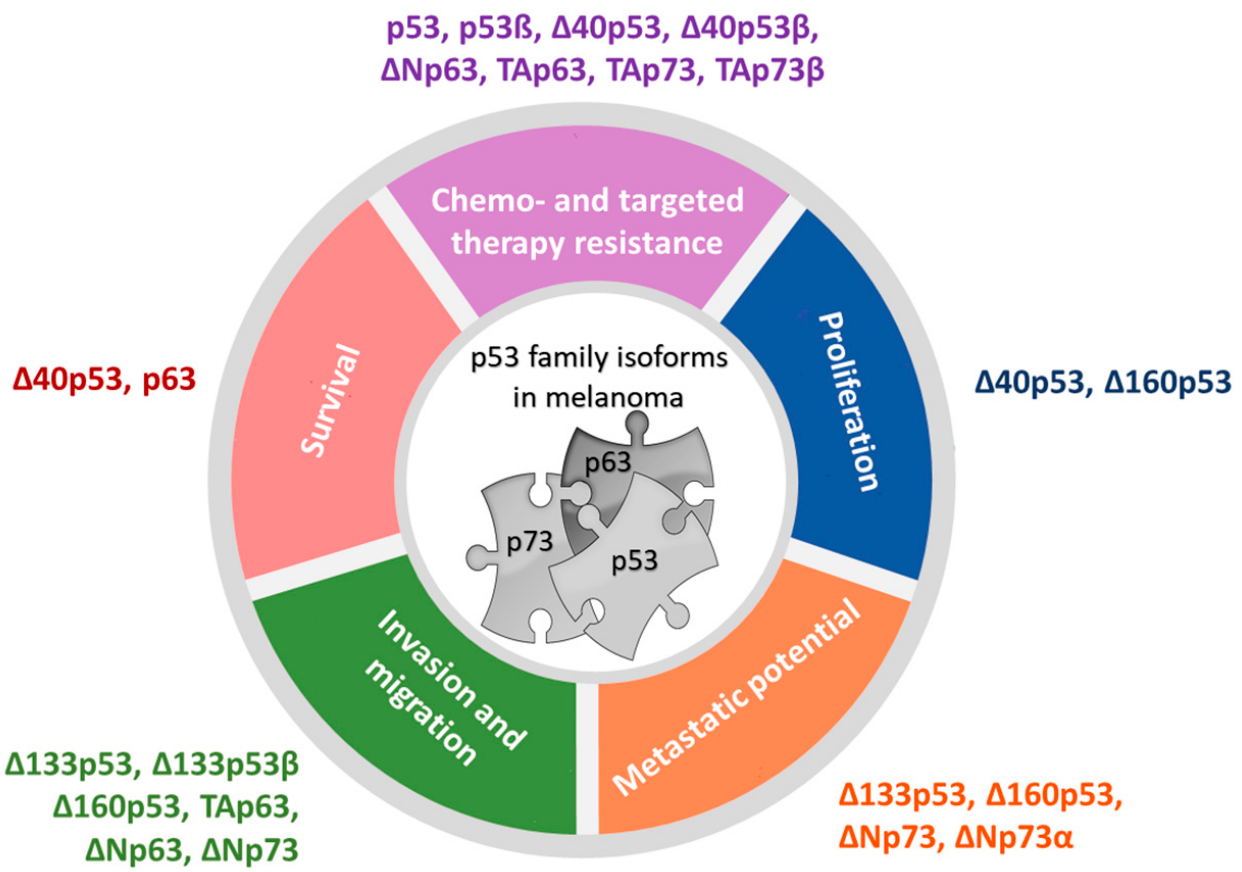
Figure 3. Biological functions of p53 family isoforms in melanoma (model adapted from [39]).